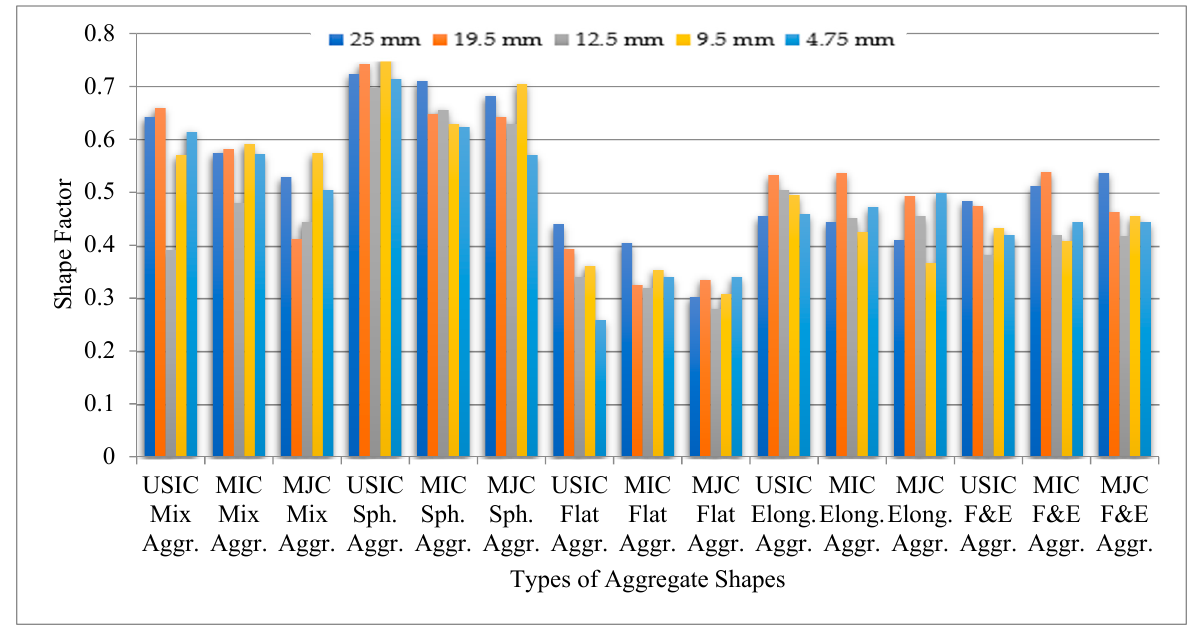
Figure 6. Shape factor of different aggregate shapes and type of crushers.